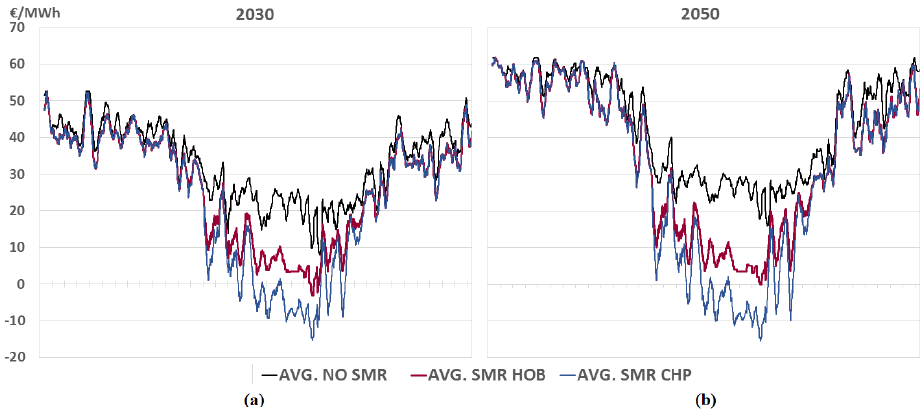
Figure 7. The modelled district heat production distribution with SMR CHP in 2050 in MW.